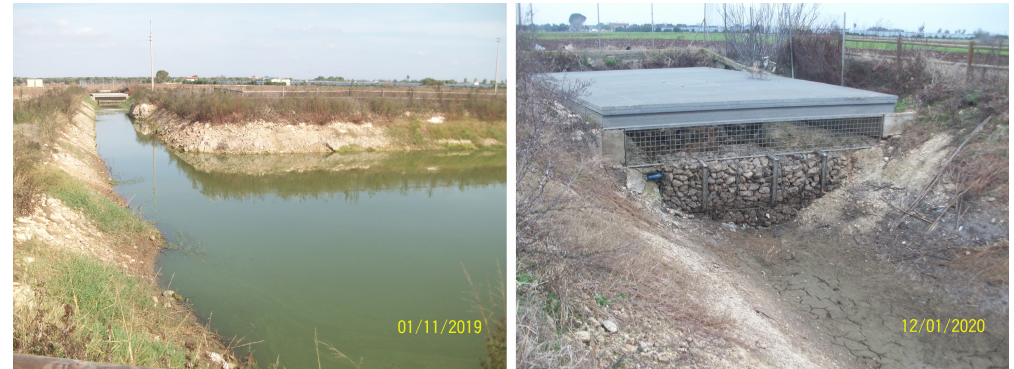
Figure 8. Left: the final course of the new channel in the beginning of November 2019; the hydrometric level was at a mean height, despite only 115 mm of rain in the previous four months; right: the entrance of Vora Manieri hole in the middle of January 2020; the brownish mud that covers the channel bed could cause clogging processes in the swallow